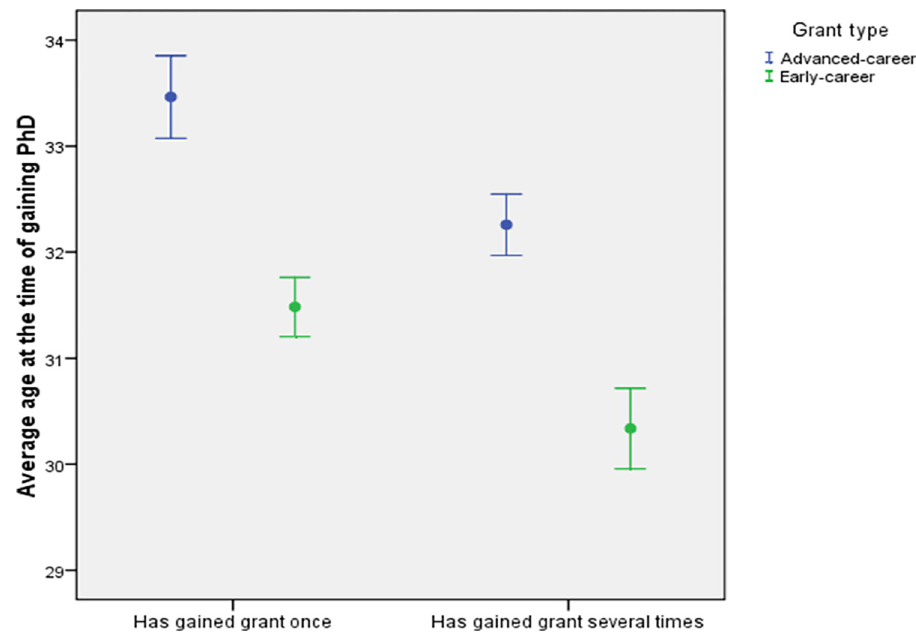
Fig 12. Average age at the time of gaining PhD ( ± SE) in relation to success of obtaining the grant once or multiple times for different grant types (early vs. advanced). The comparisons are based for all grants awarded by the Estonian Research Council between